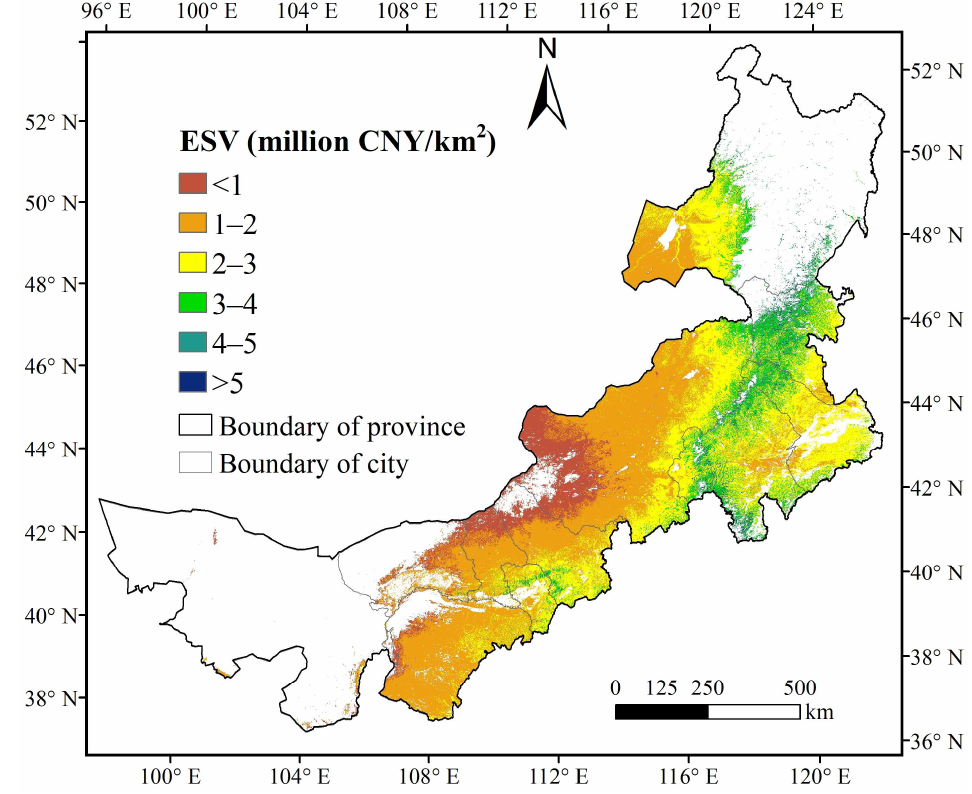
Figure 4. Spatial distribution of average grassland ESV in Inner Mongolia from 2000 to 2019. Table 4. Area ratio of average grassland ESV in Inner Mongolia from 2000 to 2019.